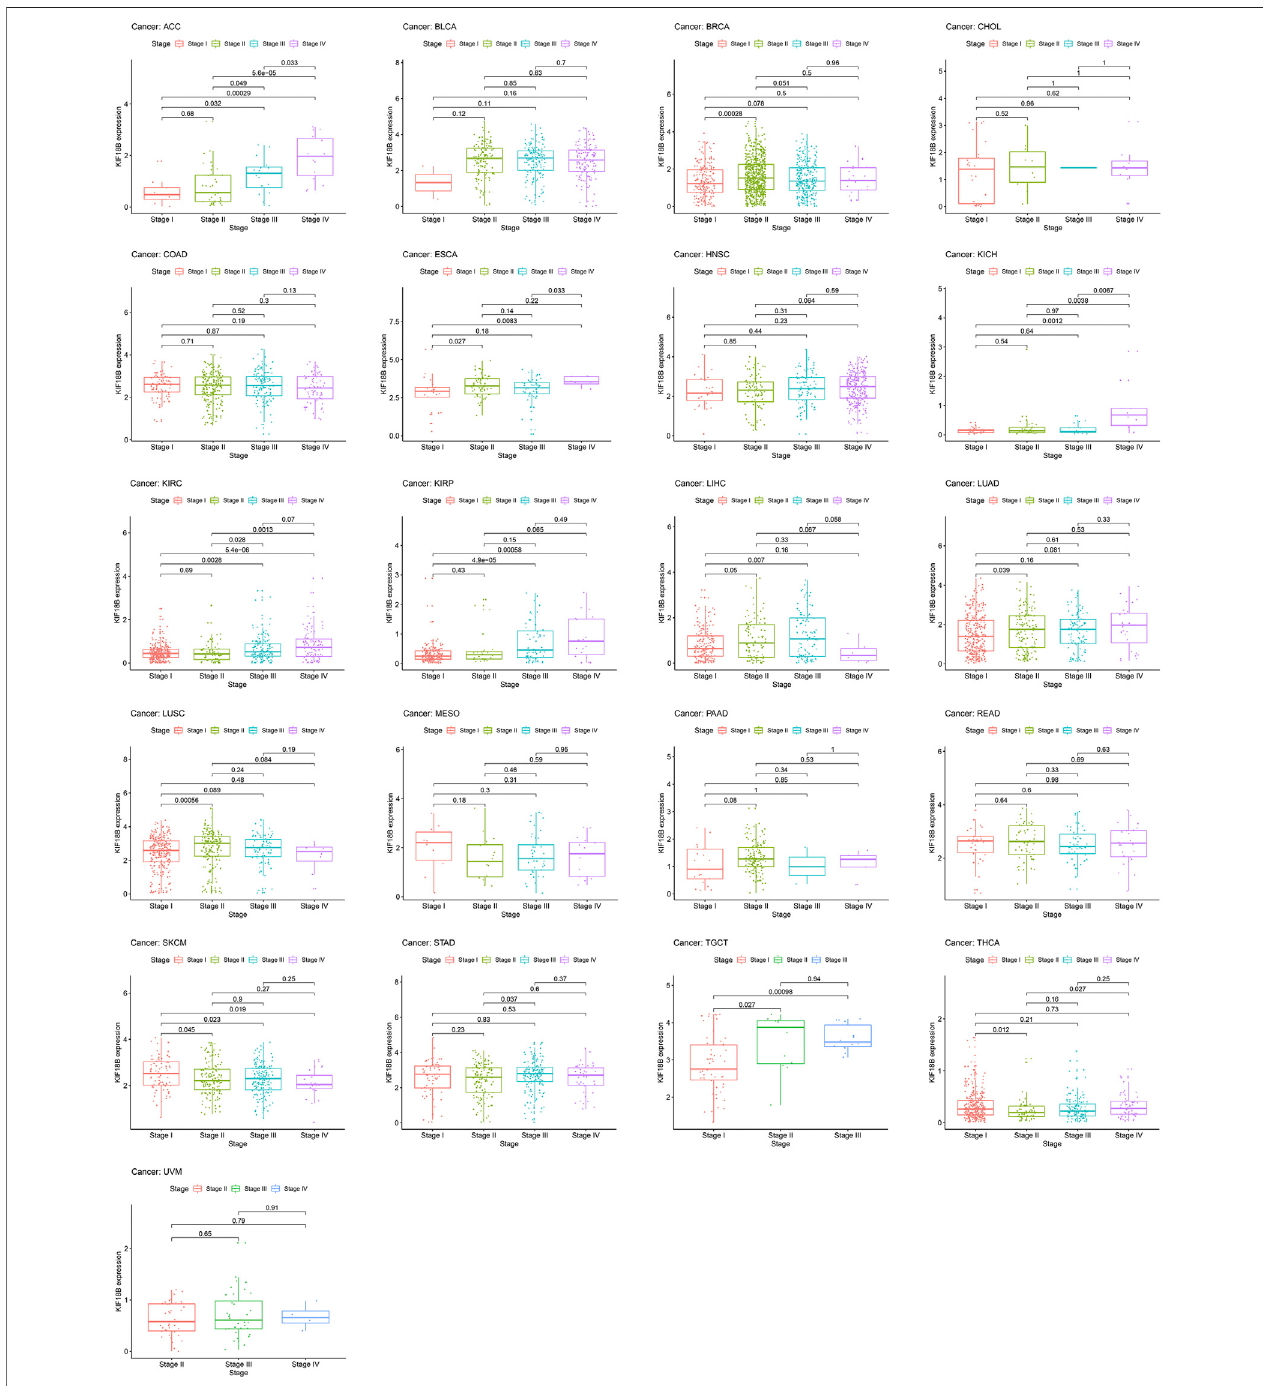
FIGURE 4 | The correlations between KIF18B expression and pathological stages in various cancers.